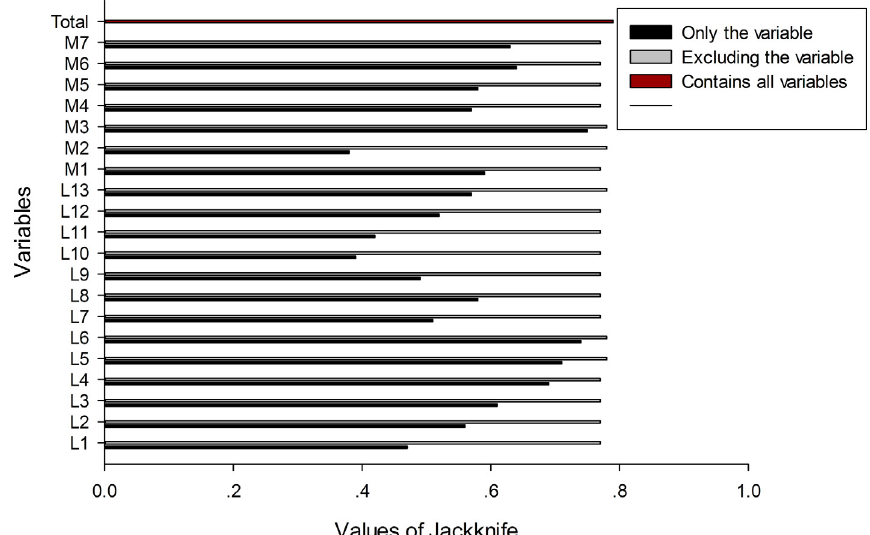
Figure 2. Relative importance of meteorological variables in predicting the probability of F. hepatica infestation, as determined by the jackknife analysis. Variables producing higher trainings gain are considered to be more important (more predictive). L1 – Water;